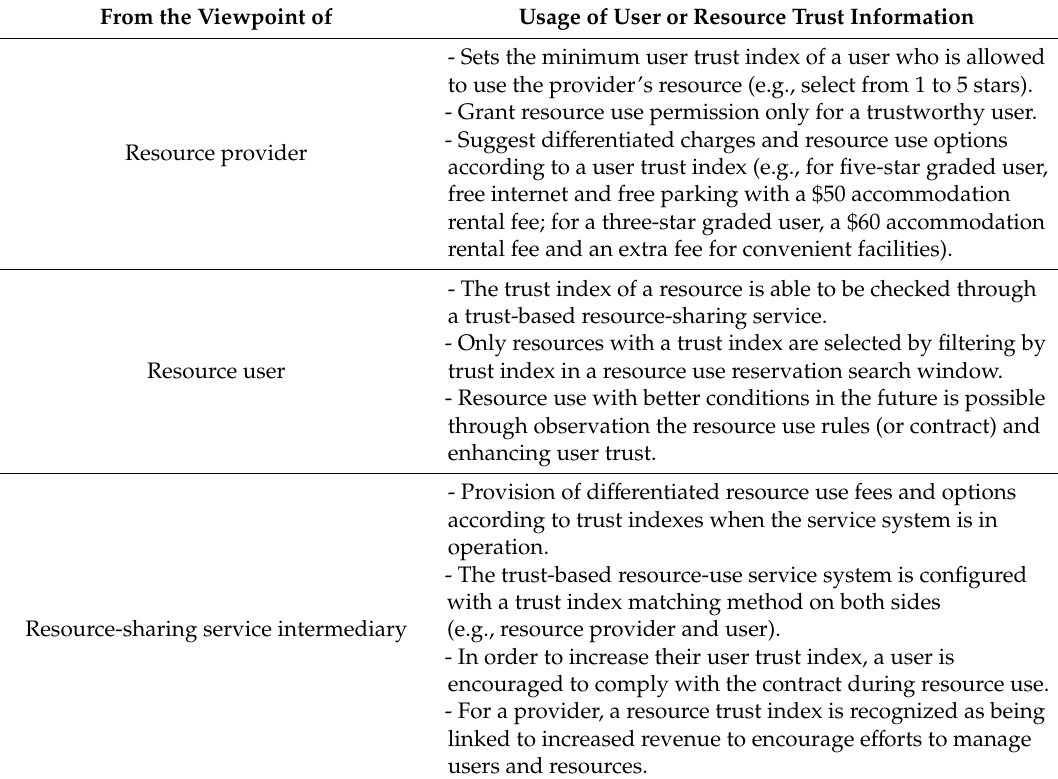
Table 1. Usage of user or resource trust